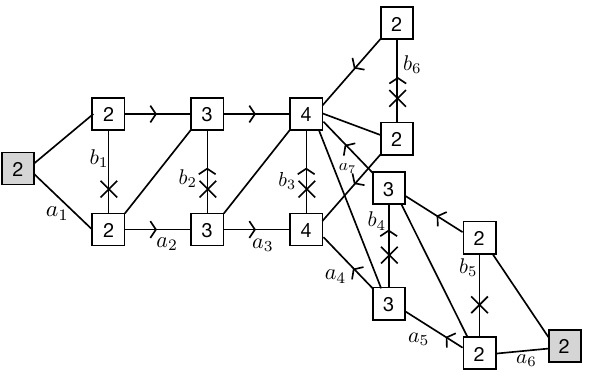
Figure 18 . Basic domain walls in the minimal E 7 theory with D 1 = f + 7 g (cid:12)